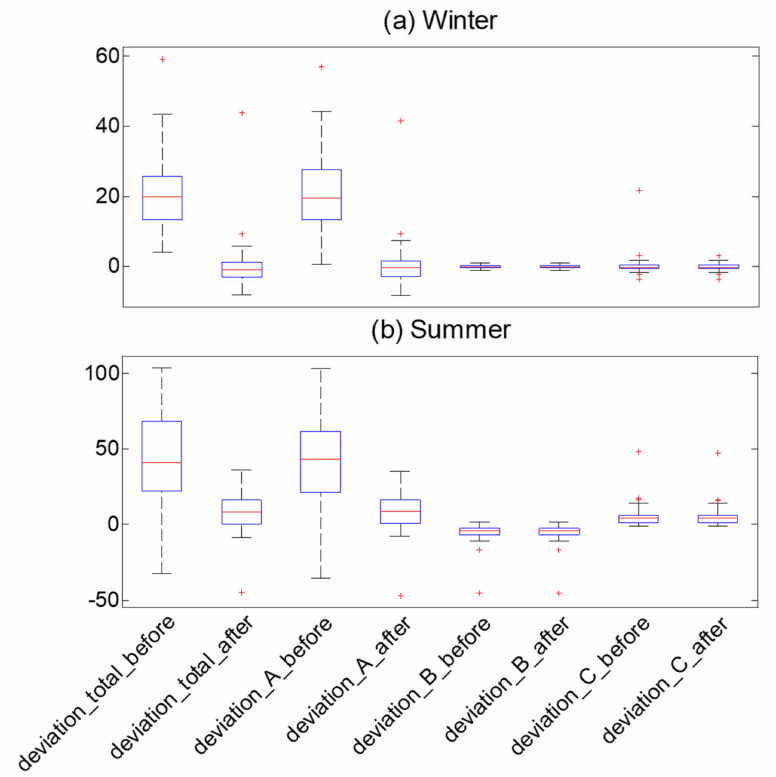
Figure 8. Comparison before and after correction of annual precipitation differences for the period 2000–2004: ( a ) winter (mm) and ( b ) summer (mm). The total difference includes three components A, B and